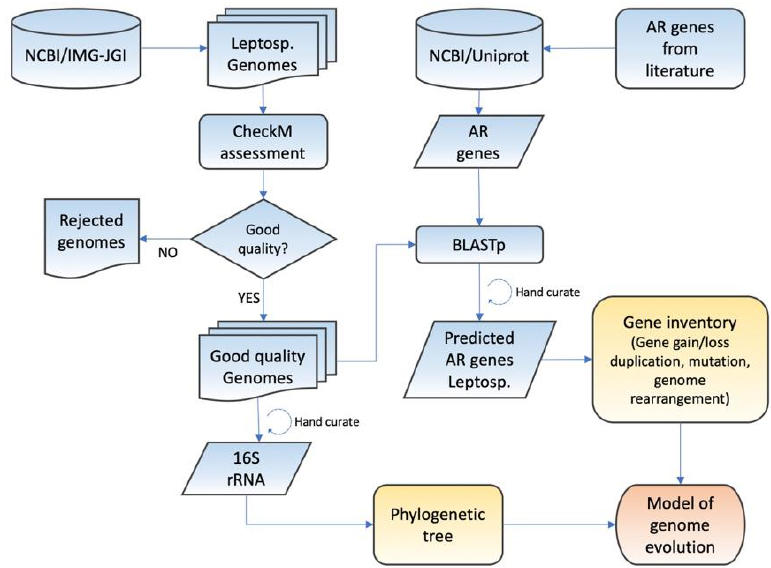
Figure 1. Bioinformatic pipeline outlining the strategy used for developing a model of the evolution of acid resistance (AR) mechanisms in the extremely acidophilic. Leptosp. = Leptospirillum genus.